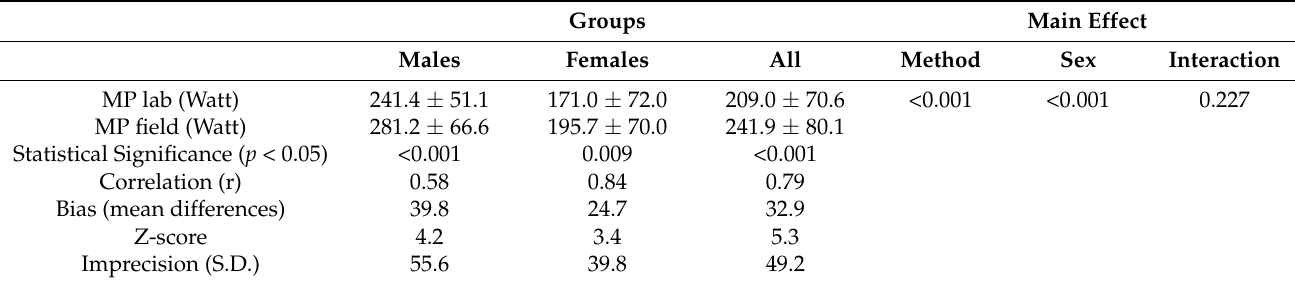
Table 4. Comparison between estimated and measured muscle